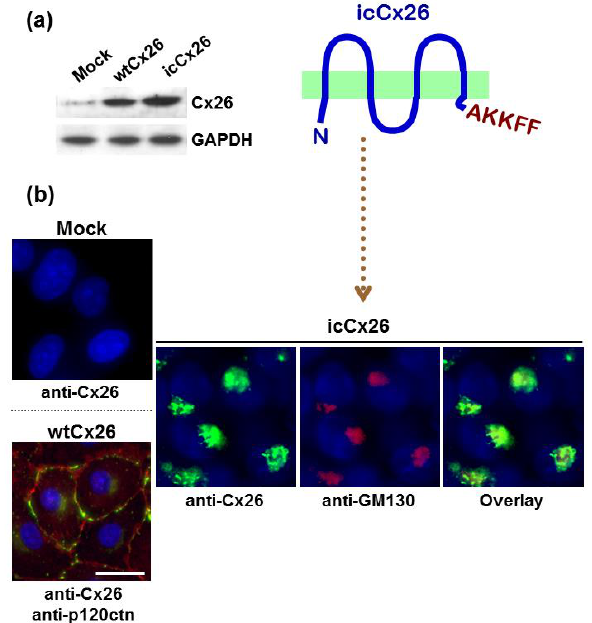
Figure 1. Expression and subcellular localisation of wtCx26 or icCx26 protein in the FaDu clones retrovirally-transduced by each construct examined. ( a ) Immunoblotting of Cx26 protein expressed in the wtCx26, icCx26, and mock clones. The expression of glyceraldehyde-3-phosphate dehydrogenase (GAPDH) was examined as a loading control. ( b ) Indirect immunofluorescence of Cx26, p120catenin (p120ctn), and GM130 proteins in the FaDu clones. The fluorescent signals of p120ctn protein were visualised by Alexa-568 (orange to red) and indicate a juxtamembrane area in the wtCx26 clone. Nuclei were stained with diamidine phenylindole dihydrochloride (DAPI). Note that signals of both Cx26 and GM130 proteins are co-localised in the icCx26 clone (overlay). Scale bar, 20 µm.